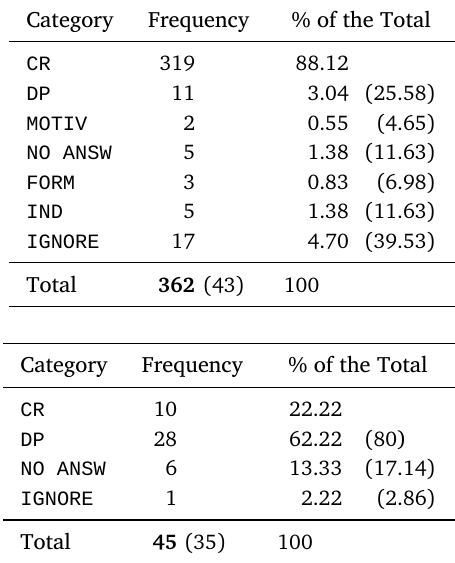
Frequency of query – query response categories (BEE) (The parenthesized percentage is the percentage recalculated once the CRs are excluded from the